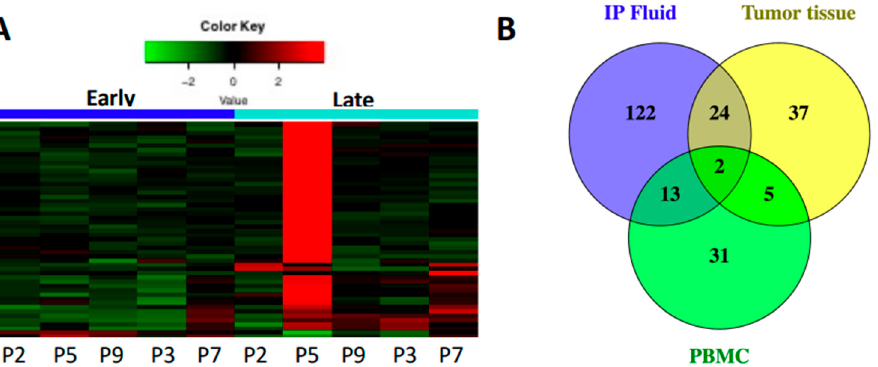
Figure 4. Immune gene expression of PBMC during chemotherapy. ( A ) Heat map for 51 DE genes between early and late time points ( p < 0.05) showing overall upregulation. ( B ) Venn diagram of IP fluid, tumor tissue and PBMC DE genes show only 2 genes are DE across all three sample types, both of which have discordant expression. Additionally, few genes are shared between PBMC and either IP fluid or tumor tissue with only around half having concordant expression.